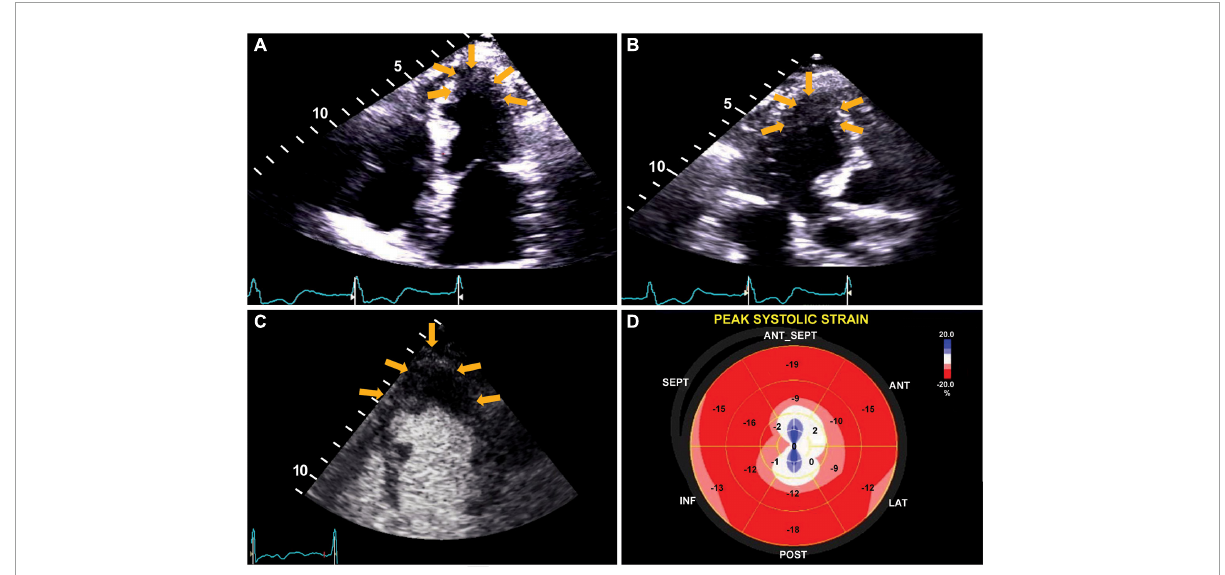
FIGURE2 Transthoracic echocardiogram. The apical four-chamber view (A) ( Supplementary Video 1 ), apical long-axis view (B) ( Supplementary Video 2 ), and definity contrast echocardiogram (C) ( Supplementary Video 3 ) show apical wall thickness (yellow arrows). Panel (D) shows strain analysis with markedly reduced peak systolic strain and evidence of dyskinesis in the apical segments.